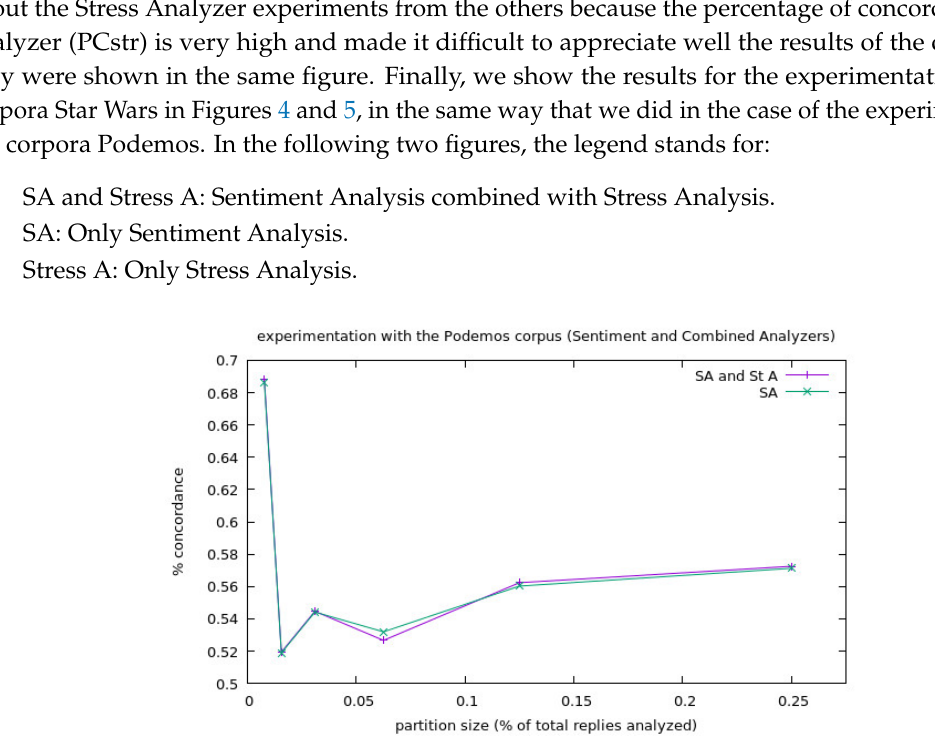
Figure 2. Results of the experiments with the corpora Podemos for the Sentiment Analyzer and the Combined Analyzer.